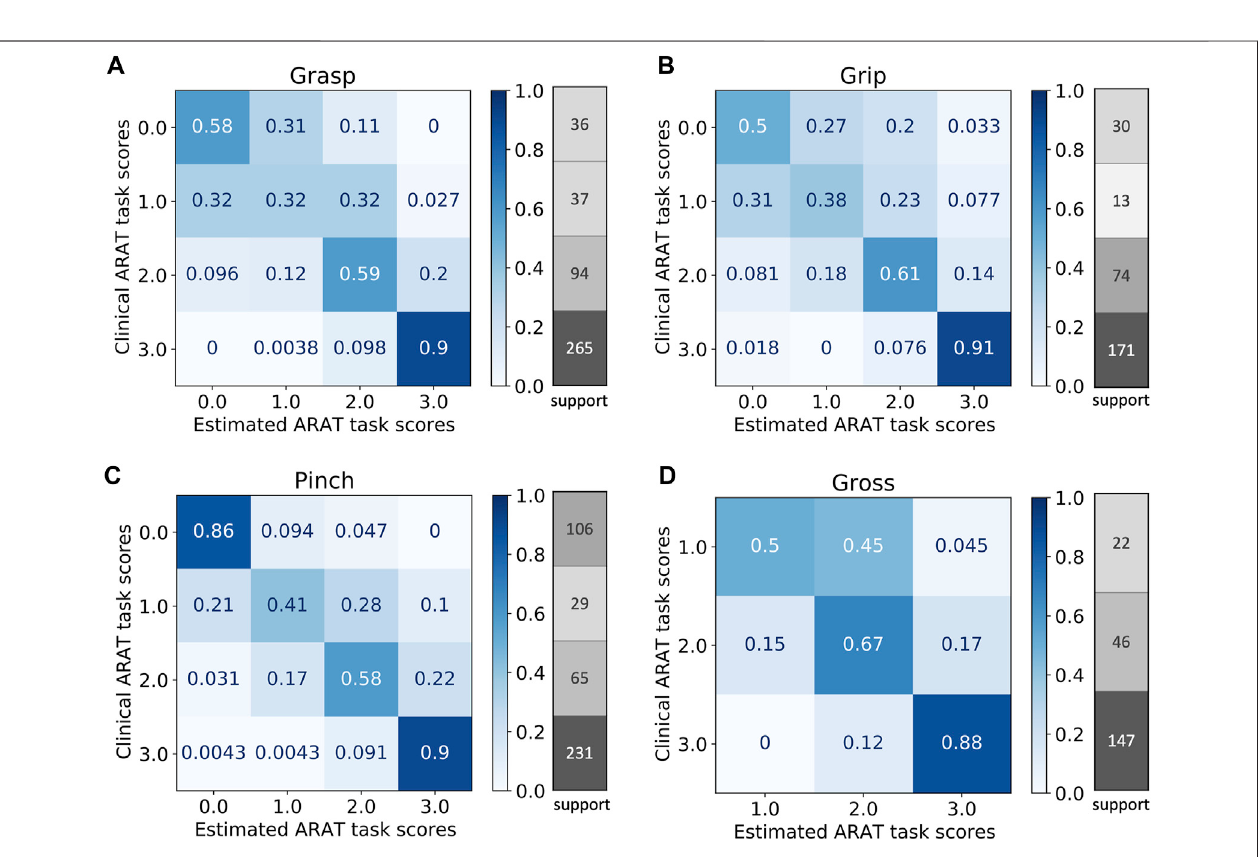
Frontiers in Physiology |